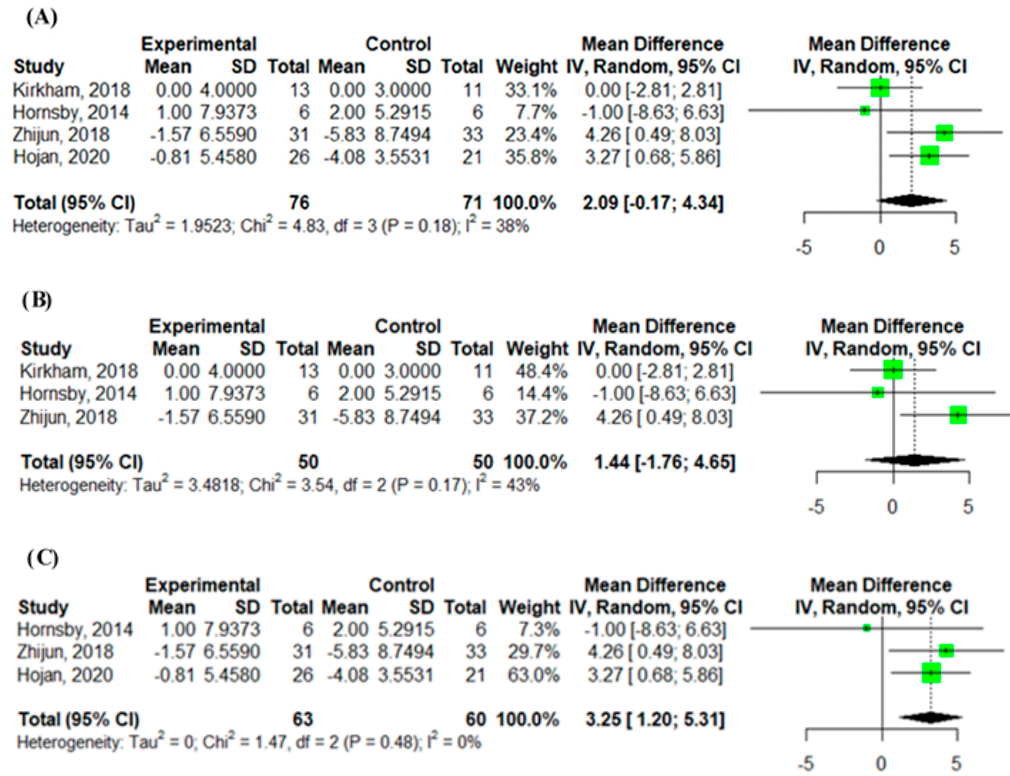
Figure 3. Forest plot showing the effect of exercise intervention compared to control on resting left ventricular ejection fraction: ( A ) from the included trials; ( B ) from the trials conducted during anthracycline-containing therapy; ( C ) from the trials that implemented interventions involving ≥ 36 exercise sessions.